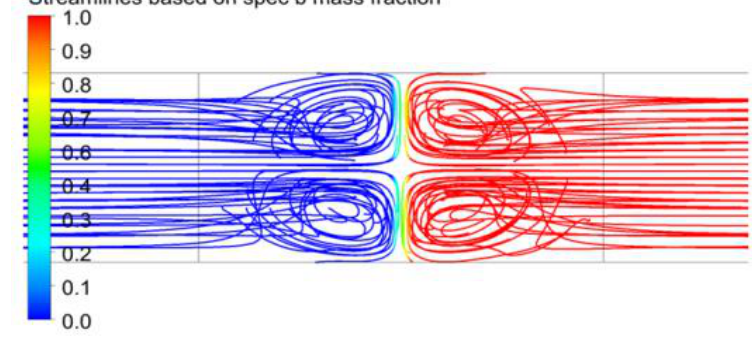
Figure 6. Streamlines at the junction of T-mixer at Re =